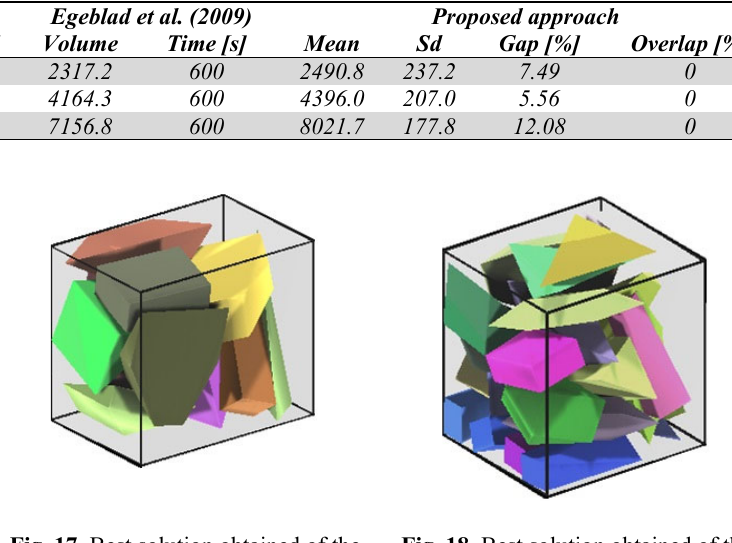
Fig. 18. Best solution obtained of the instance SGSPM05 c25